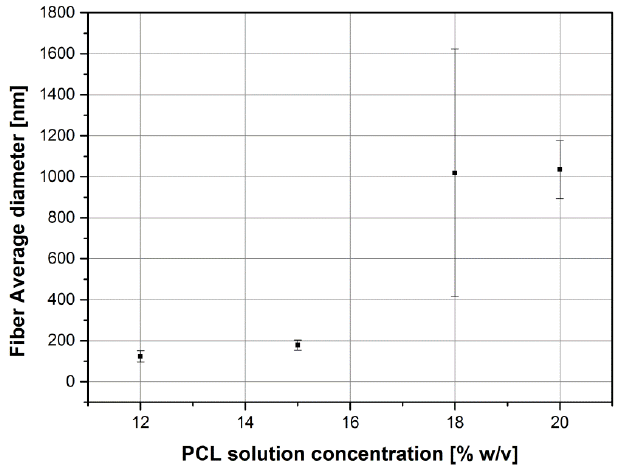
Figure 2. Trend of the PCL mats average fiber diameter as function of the PCL solution concentrations.